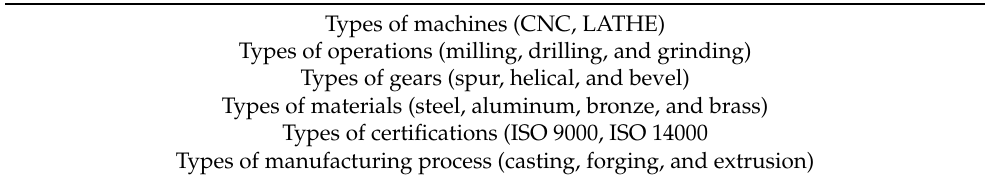
Table 3. Information to be extracted from mining and gear classification